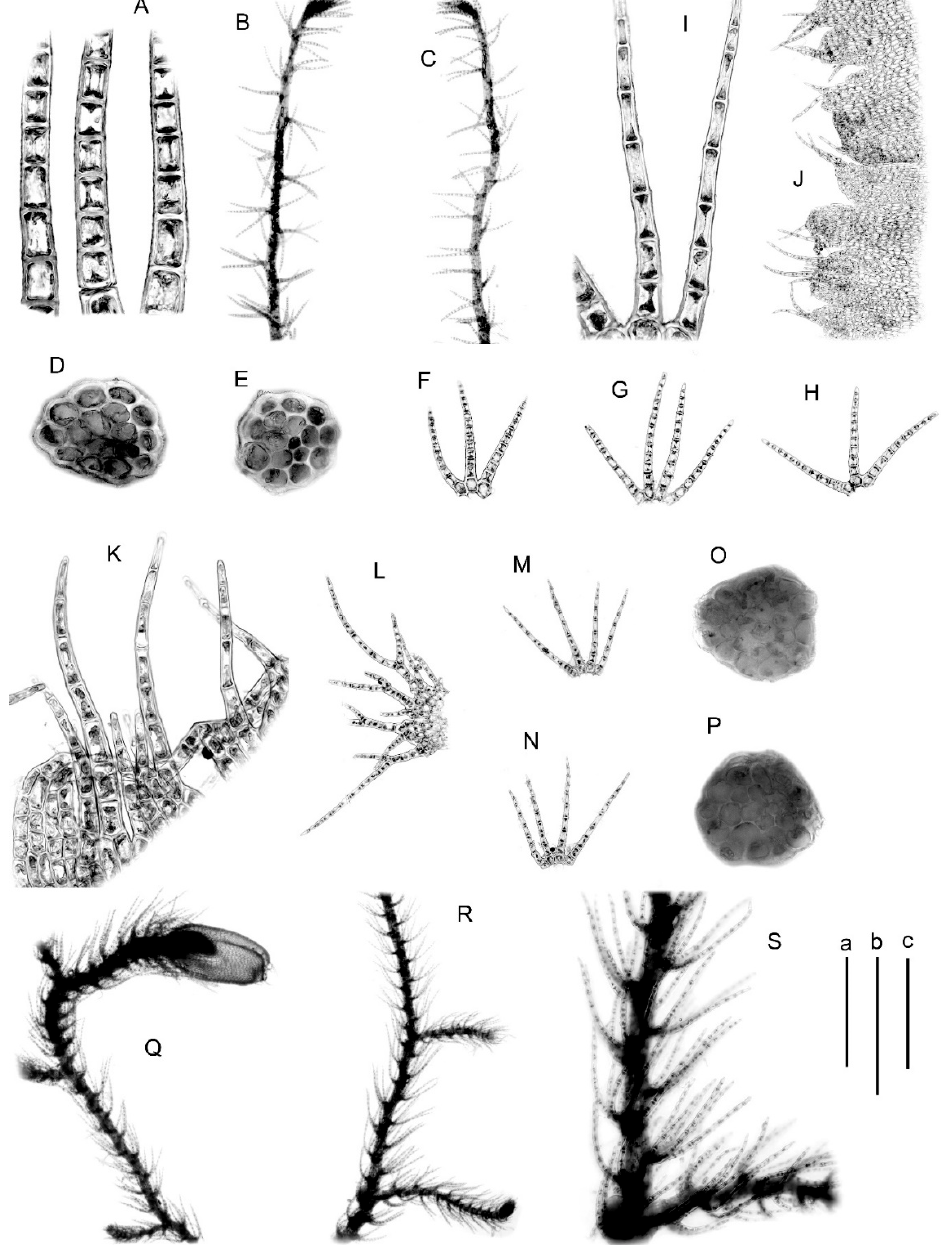
Figure 6. ( A) –( H ) Blepharostoma trichophyllum x hybrid1 , from Mag-57-2-11 (VBGI); ( I) –( S ) B. neglecta , Figure 6. ( A – H ) Blepharostoma trichophyllum x hybrid1 , from Mag-57-2-11 (VBGI); ( I – S ) B. neglecta , from S-48-18-16 (VBGI). ( A) ,( I )—leaf segments; ( B) ,( C) ,( Q) –( S )—plant habit; ( J) ,( K )—perianth mouth from S-48-18-16 (VBGI). ( A , I )—leaf segments; ( B , C , Q – S )—plant habit; ( J , K )—perianth mouth armature; armature; ( D) ,( E) ,( O) ,( P )—stem cross-section; ( F) –( H) ,( M) ,( N )—leaves; ( L )—female bract. Scales: a— ( D , E , O , P )—stem cross-section; ( F – H , M , N )—leaves; ( L )—female bract. Scales: a—1 mm, for ( B , C , Q , R 1 mm, for ( B) ,( C) ,( Q) ,( R ); b—500 µm, for ( F)–(H) ,( J) ,( L) ,( N) ,( S ); c—100 µm, for ( D) ,( E) ,( K) ,( O) ,( P ).